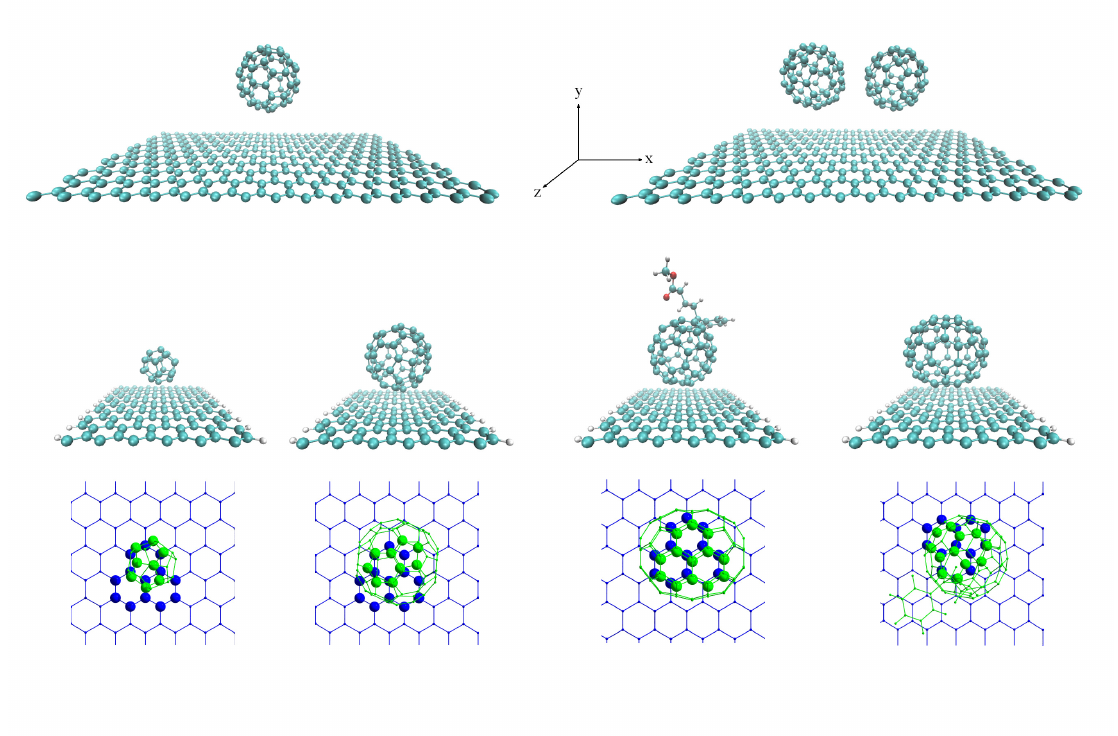
Figure 10. Schematic view of different complexes of fullerenes physisorbed onto a graphene monolayer and armchair graphene nanoribbons. On top SLG–C 60 and SLG–2C 60 and at the middle from left to right: nGR–C 20 , nGR–C 60 , nGR–PCMB and nGR–C 70 . At the bottom we show the coordination modes for each